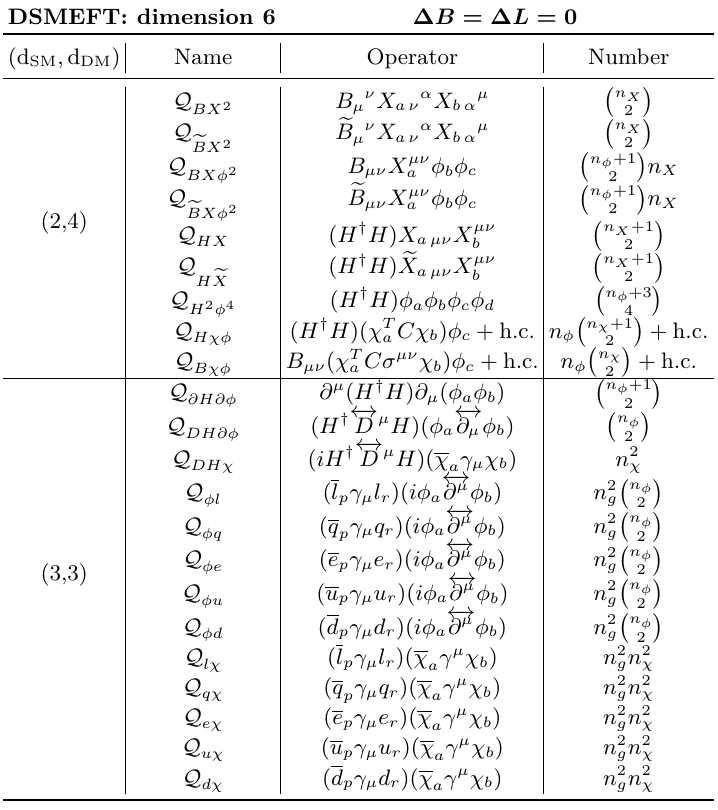
Table 11 . Dimension-six ∆ B = ∆ L = 0 operators in DSMEFT, part 1. The first column gives the dimensions of the SM and DM part of the operator, and the fourth column is the number of